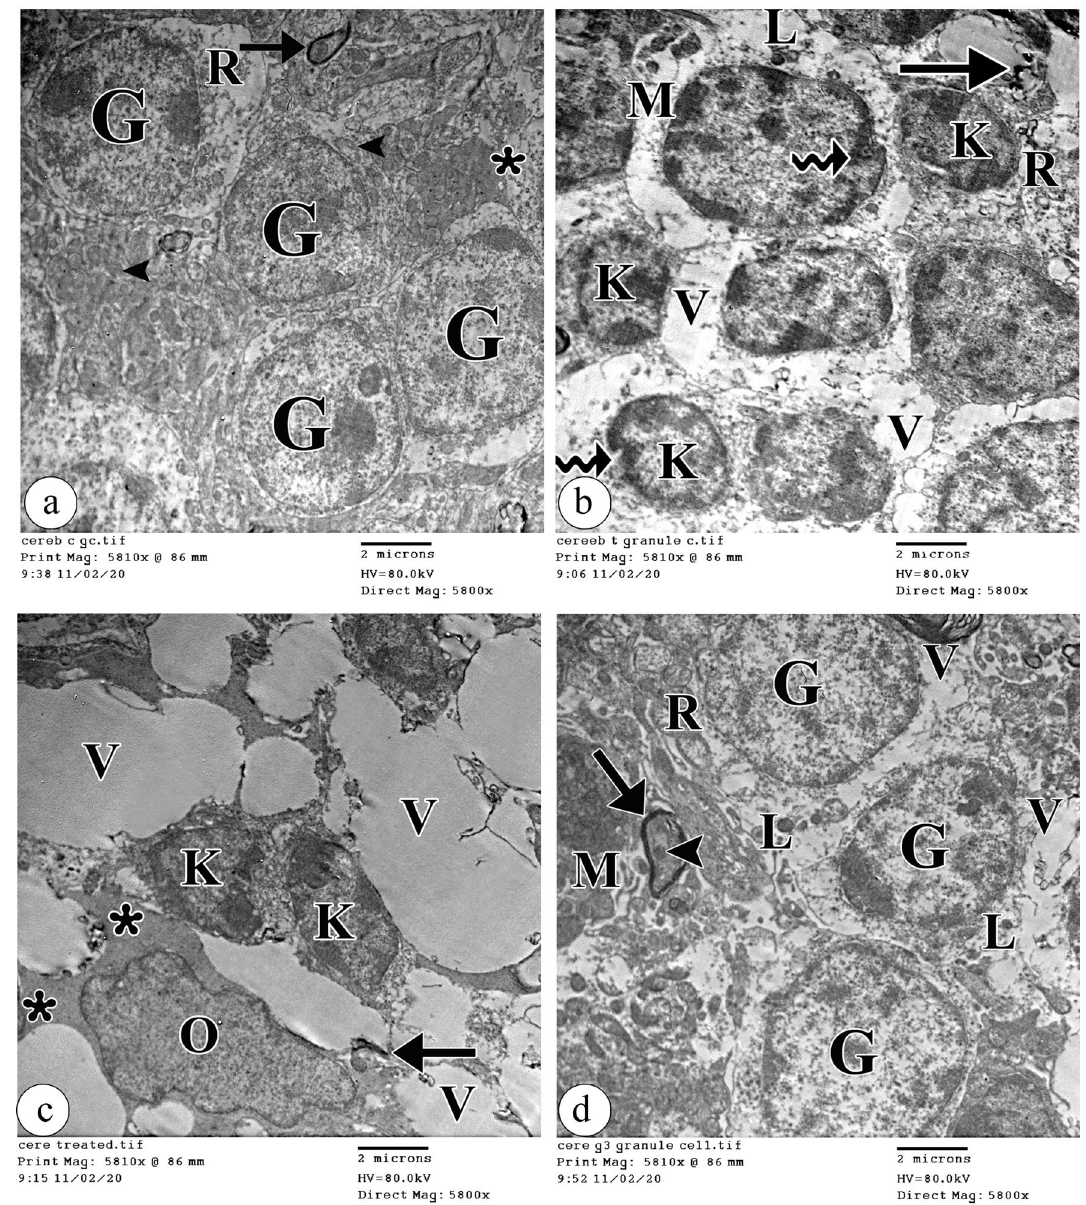
Figure 5. An electron photomicrograph of the granular cells layer in ( a ) the control group showing the crowded group of the granule cells (G) with central heterochromatic oval nuclei encircled by a thin cytoplasmic shell containing the rough endoplasmic reticulum (R), mitochondria (arrowhead) and free ribosomes (asterisk). The myelin sheath of myelinated nerve axons (arrow) is regularly compact. ( b ) the tartrazine treated group showing some granule cells (K) with pyknotic nuclei. Other granule cells reveal indentations (curved arrow) of the nucleolemma. The cytoplasm shows dilated rough endoplasmic reticulum (R), damaged mitochondria (M), lysosomes (L), and vacuoles (V). Disrupted myelinated fibers (arrow) are seen. ( c ) the tartrazine-treated group showing two granule cells (K) with pyknotic nuclei fused. The cytoplasm appears with many vacuoles (V) and a marked loss of cell organelles. Oligodendrocyte (O) with the process (asterisk) and degenerated myelinated nerve axon (arrow) is observed. ( d ) the tartrazine + riboflavin treated group showing restored the normal appearance of the granule cells (G). The cytoplasm shows dilated rough endoplasmic reticulum (R), intact mitochondria (M), lysosomes (L), and few vacuoles (V). The myelinated nerve axon (arrow) with intact mitochondria in the axoplasm (arrowhead) is noticed. (TEM, X5800, scale bar = 2